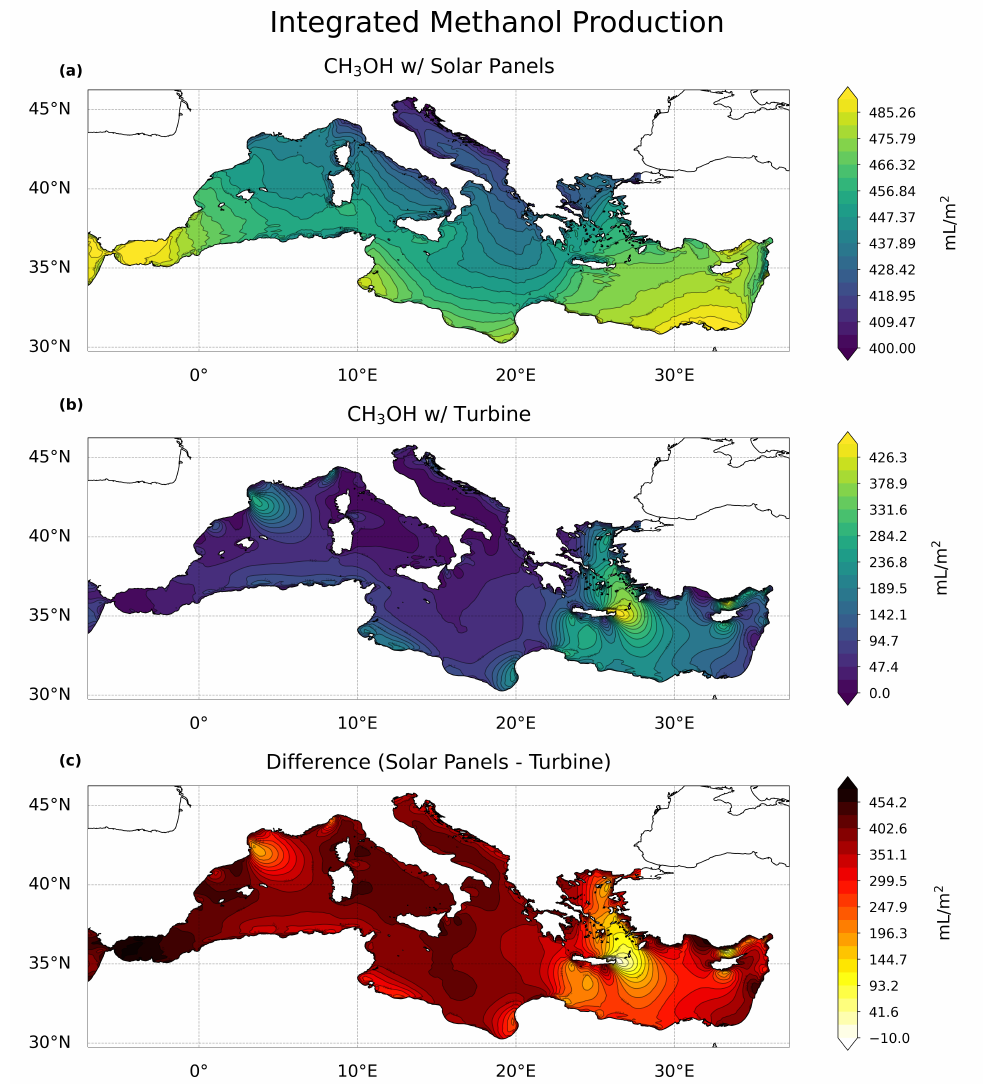
Figure 20. The integrated methanol production over the course of the ensemble averaged year for a simulated island running on solar power ( a )), wind power ( b )), and the difference between the two production simulations ( c